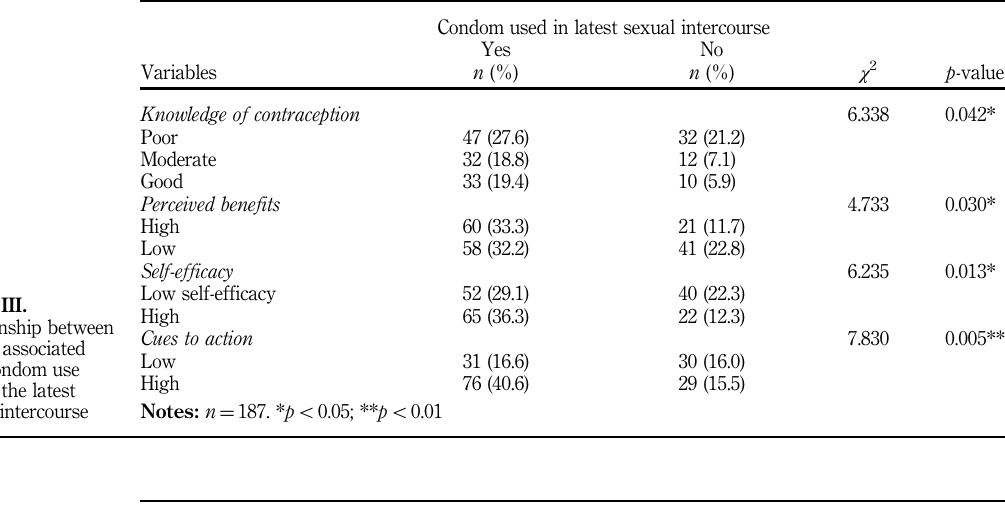
Contraceptive used in the latest sexual intercourse Yes No